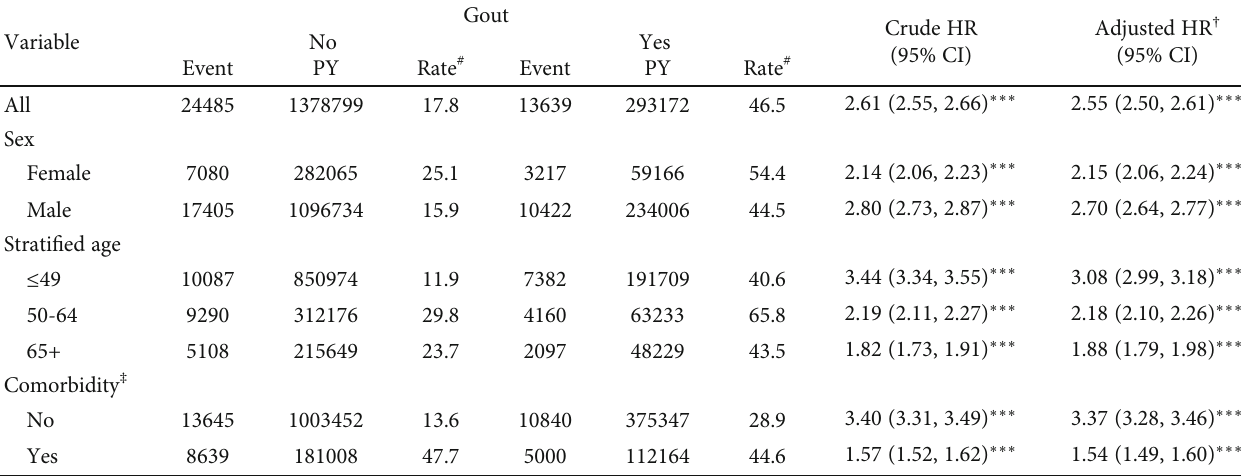
Table 3: Comparison of incidence and hazard ratio of hyperlipidemia strati fi ed by sex, age, and comorbidity between patients with and without gout.